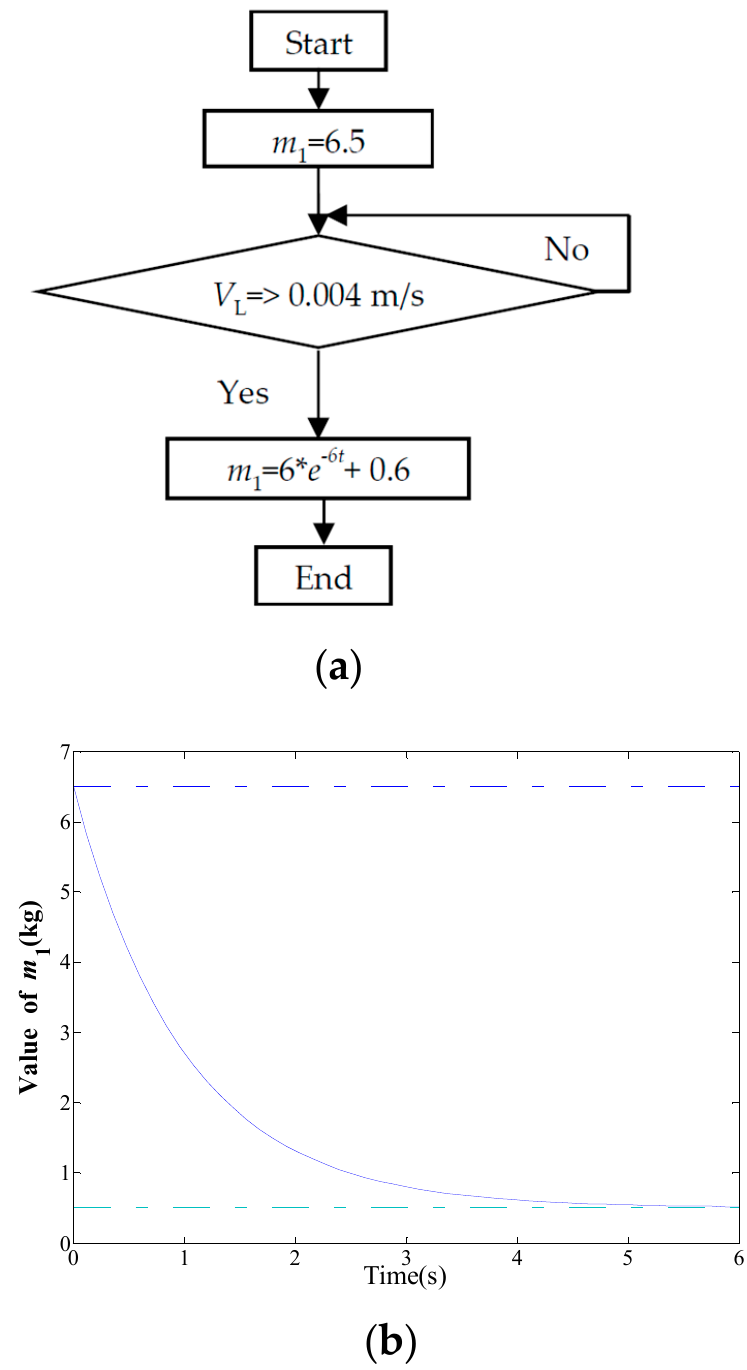
Figure 8. The flowchart for the novel adaptive control algorithm ( a ) and the hypothetical time trajectory of m 1 for lifting the PAO when the novel control algorithm is implemented ( b ).